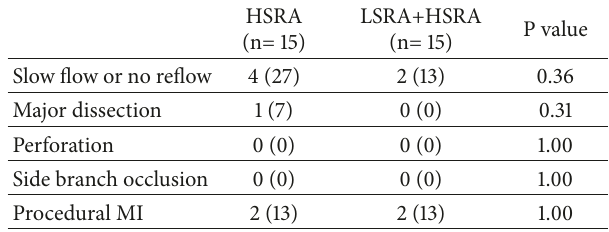
Table 4: In-hospital